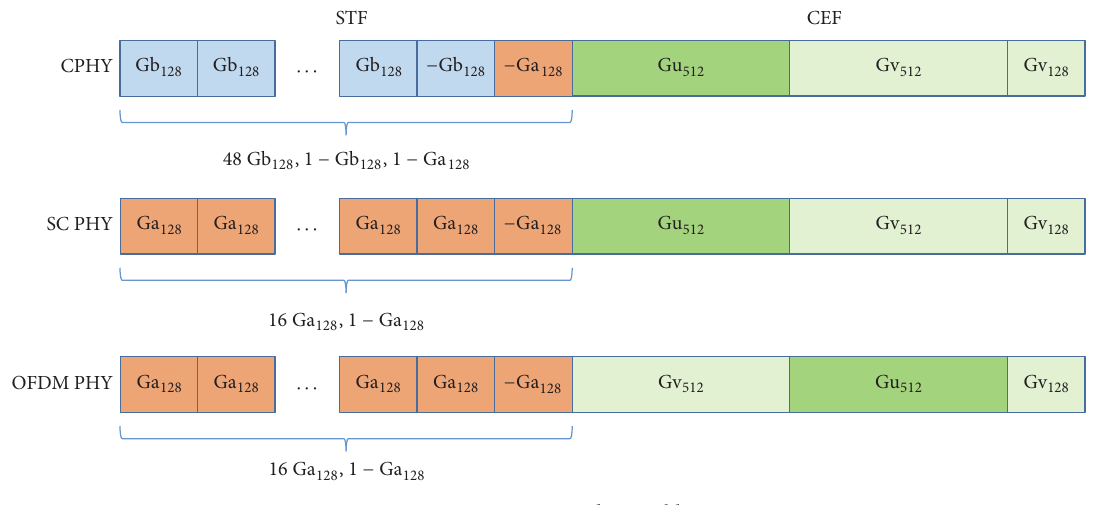
Figure 5: WiGig/IEEE 802.11ad preamble structure.